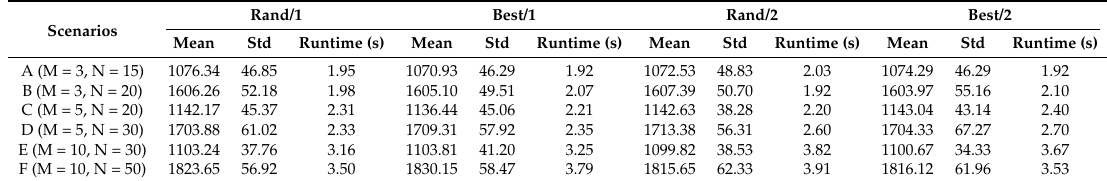
Table 1. Performance comparison of Delete-and-Insert Differential Evolution (DIDE) with different mutation